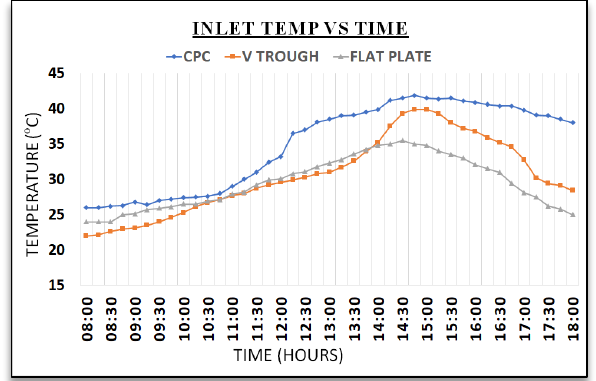
Figure 19. Inlet Temp. vs Time values observed for the Flat plate, V Trough and CPC Collector